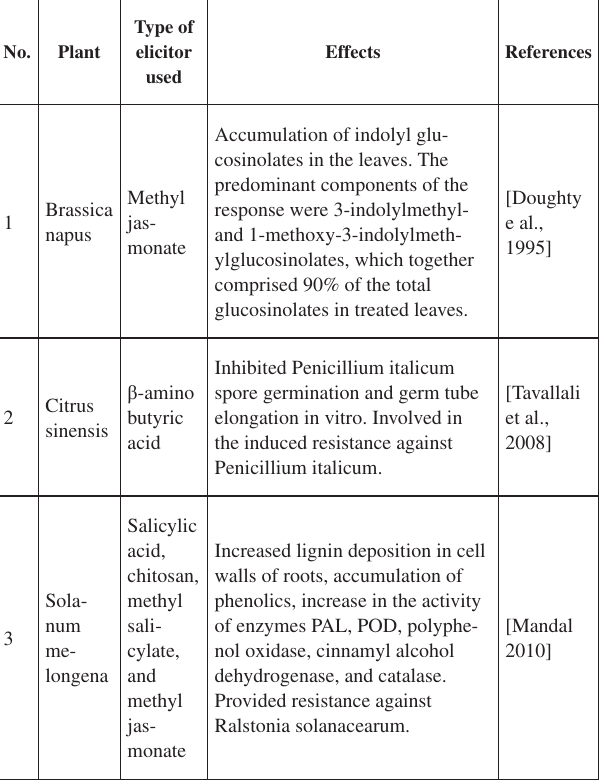
Table 1: List of elicitors used and their effects on different plant species